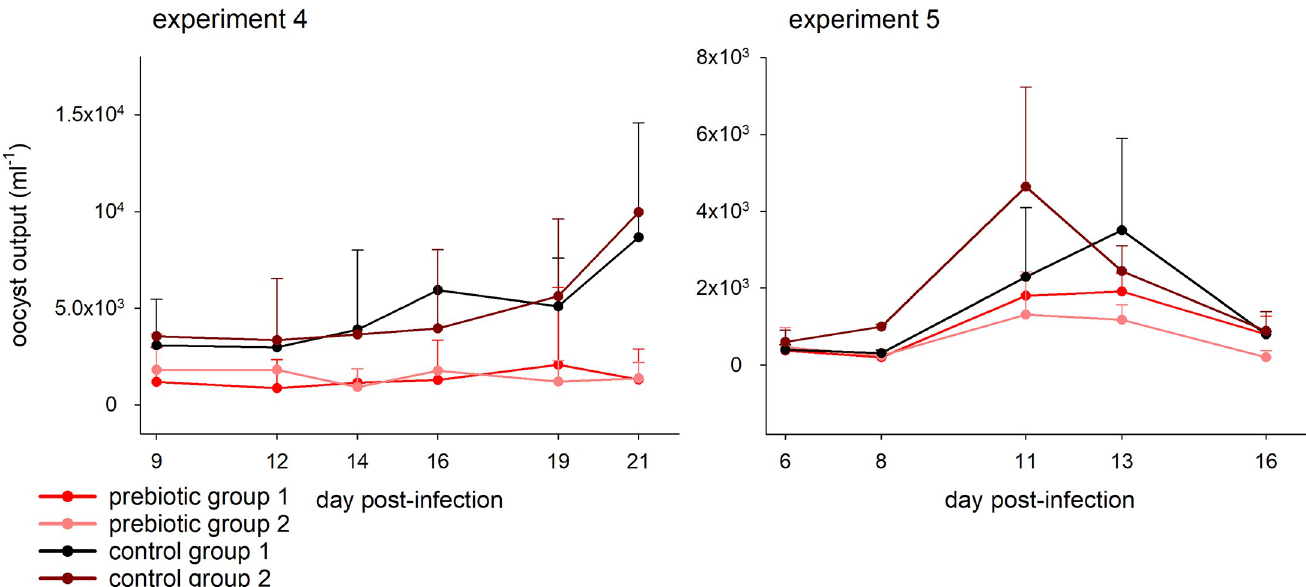
Fig 2. Effect of prebiotic on severity of C . parvum and C . tyzzeri infection. Datapoints represent mean of 4 mice (experiment 4) and 3 mice (experiment 5). Error bars show SD. Color indicates treatment as follows: red and pink, supplemented with prebiotic; black and brown, control. See Fig 1 legend, Table 1 and Materials and Methods for details.